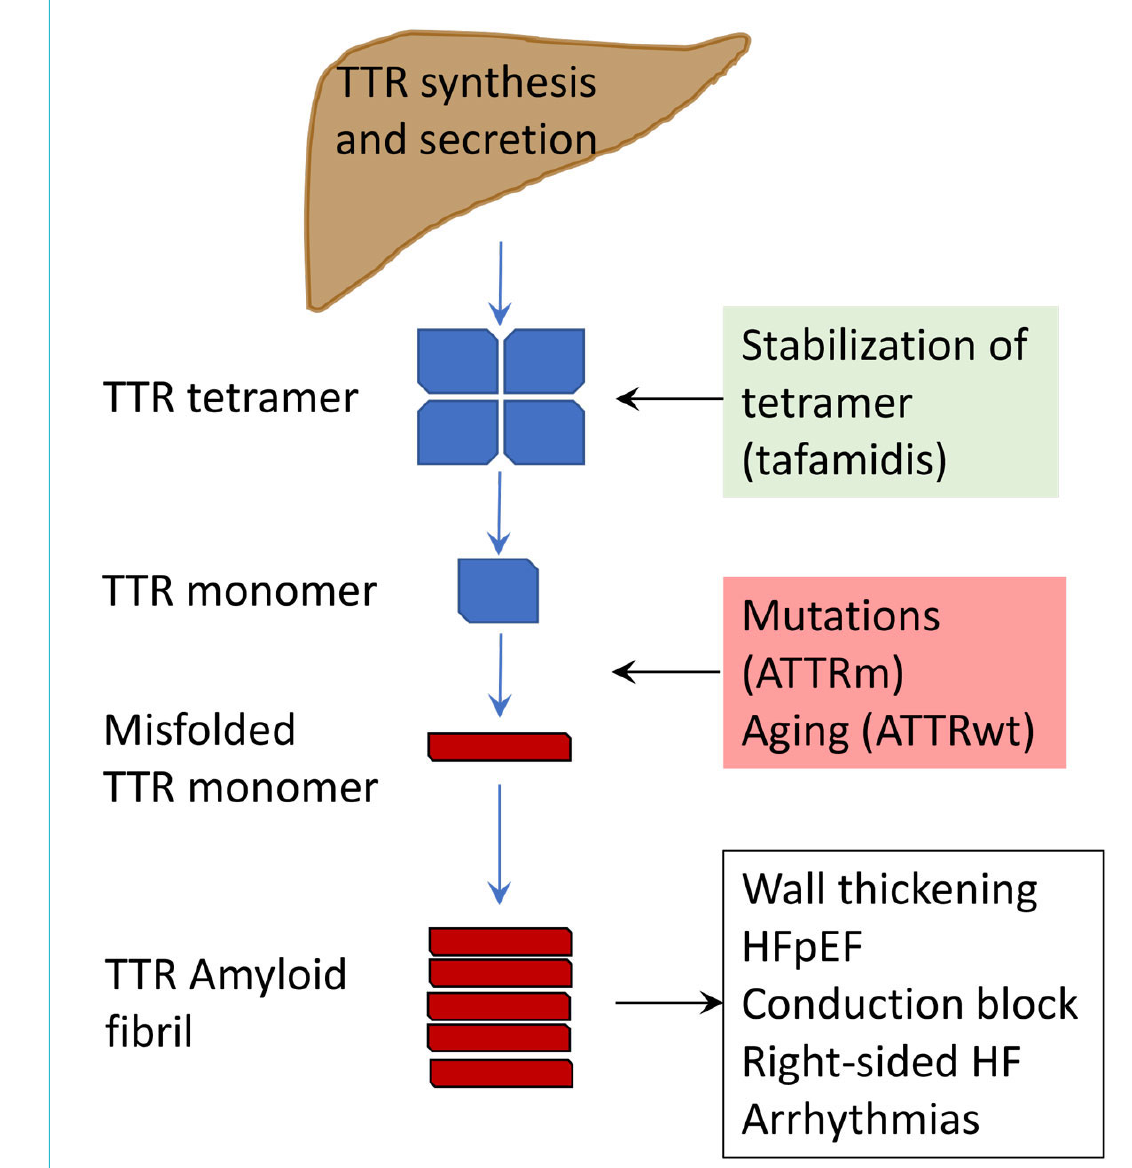
Figure 4: Secretion and metabolism of transthyretin. Transthyretin (TTR) is synthesized and secreted by the liver and assembles to tetramers. Dissociation of the TTR tetramer leads to the occurrence of monomers, which are prone to denaturalization and misfolding either through mu- tations (ATTRm, hereditary forms) or during aging (ATTRwt). Misfolded TTR polymerizes to form amyloid fibrils that are deposited in various organs including the heart. Tafamidis (and other compounds, e.g., diflunisal) can stabilize TTR in its tetramer formation, thus preventing mis- folding and amyloid